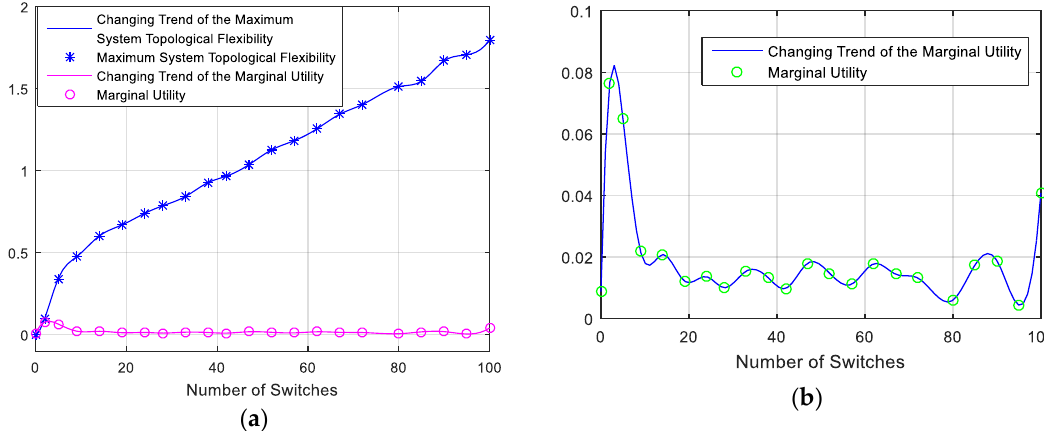
Figure 7. Analysis of the maximum system topological flexibility when the topological flexibility metric is not revised. ( a ) Maximum system topological flexibility and its marginal utility; ( b ) marginal utility of the maximum system topological flexibility.